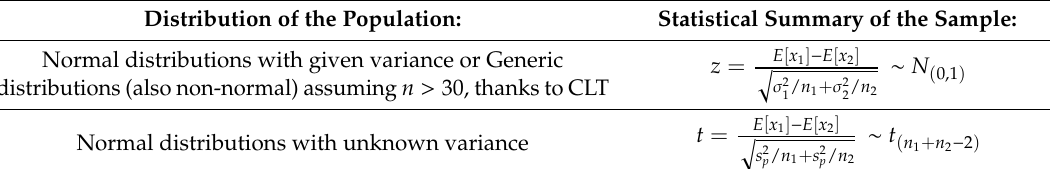
Table7. Statisticalsummaryofthesampleasafunctionofthepopulationdistributionandnumerousness n of the sample. Distribution of the Population: Statistical Summary of the